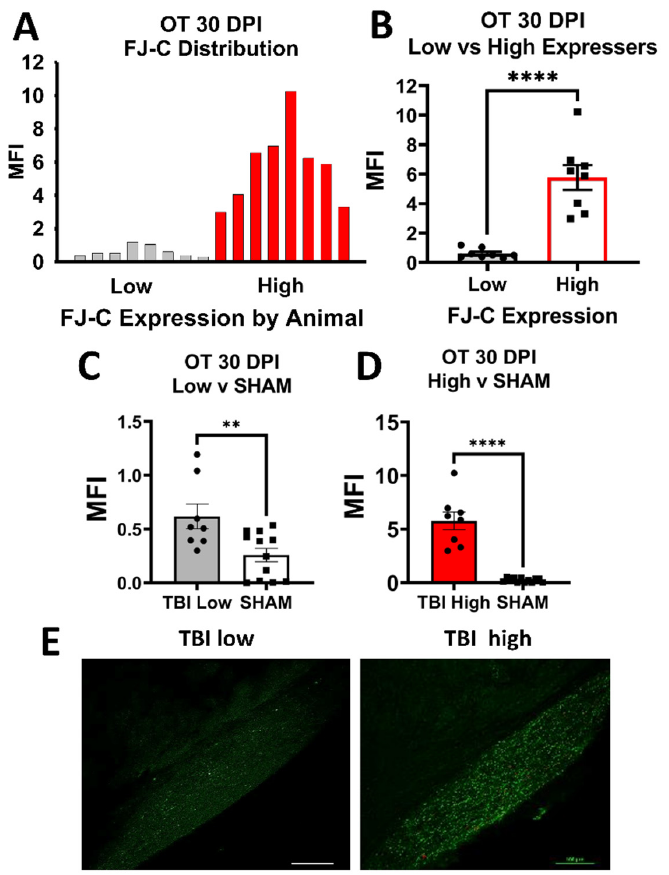
Figure 3. FJ-C expression showed distinct bi-modal characteristics in the OT at 30 DPI. ( A ) We plotted a frequency distribution of FJ-C MFI in TBI mice only and saw two clear distributions of “low” and “high” FJ-C expression. ( B ) These two groups were significantly different from each other potentially indicating inherent differences in recovery from, or susceptibility to, injury in the model of optic axonal injury. ( C ) Low FJ in TBI mice, however, was still significantly high than sham-injured mice ( D ) as were high FJ-C expressing mice. ( E ) We can clearly see little to no degeneration in the low group compared to the high with these representative photomicrographs taken at 20 × magnification. Scale bars represent 100 µ m. MFI: Mean Fluorescence, OT: Optic Tract, Intensity, ** p < 0.01, **** p < 0.0001.